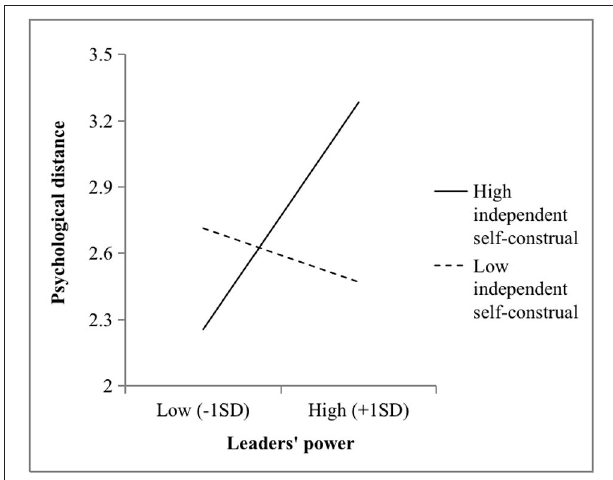
FIGURE 4 | Two-way Interaction effect between the power and independent self-construal of the leaders on psychological distance in Study 2.